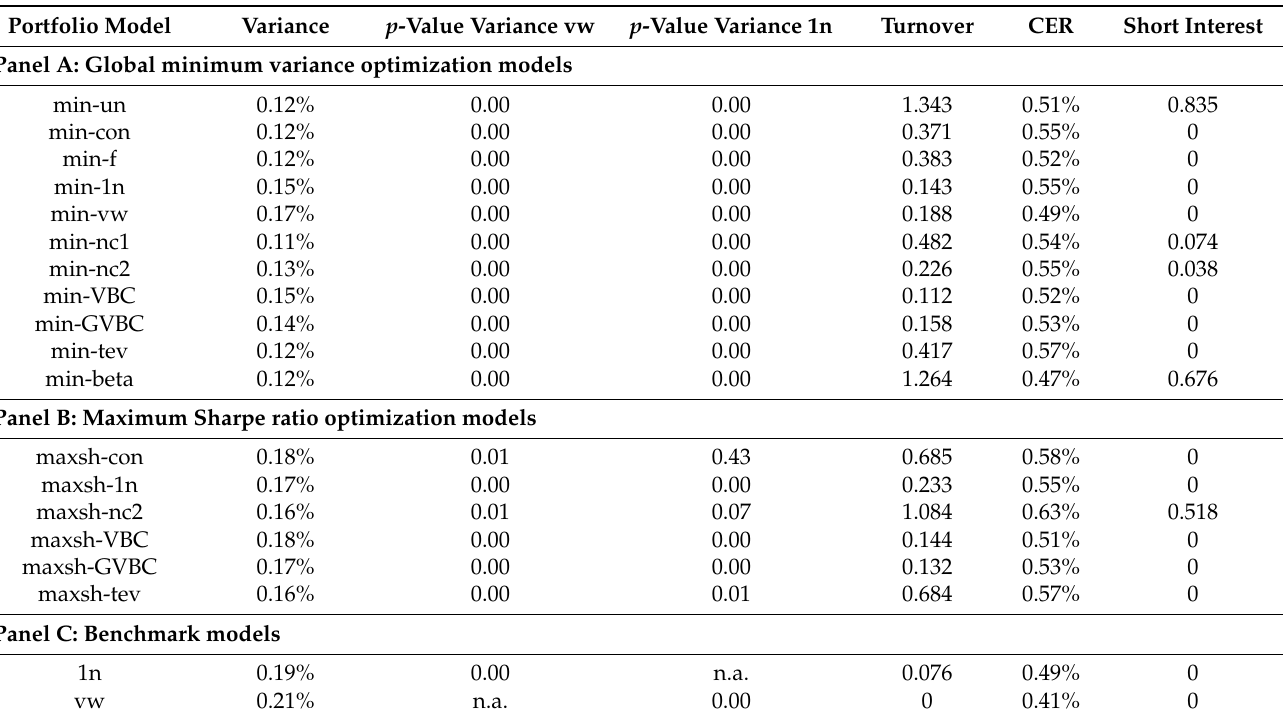
Table 4. Variance, turnover, and short interest of